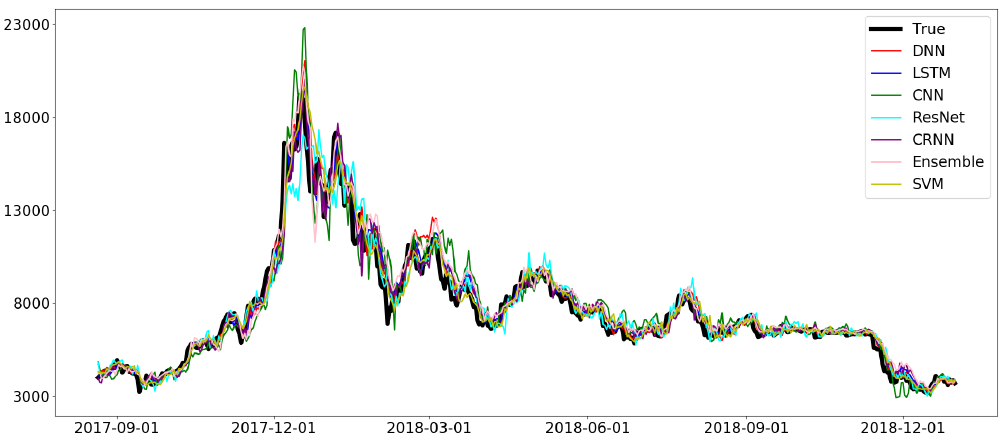
Figure 12. Prediction results of the proposed models with m = 20. The log values of the major features, the sequential partitioning, and the first value-based normalization were used.